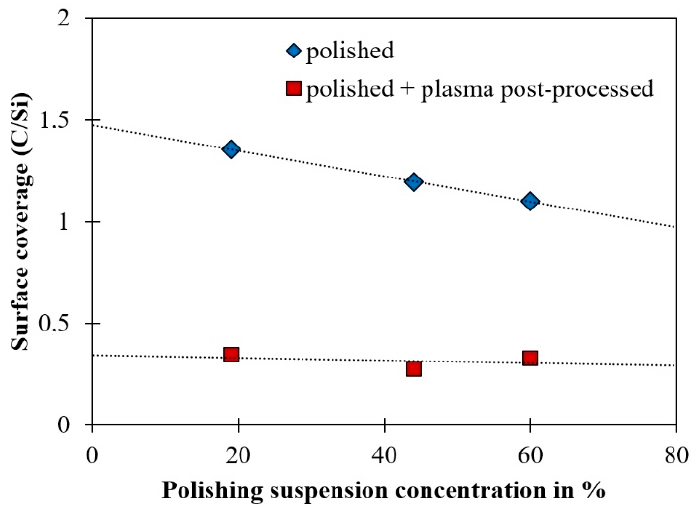
Figure 8. Comparison of the surface coverage by carbon (i.e., the ratio of carbon and silicon) of zinc crown glass samples before and after plasma post-processing vs. polishing suspension concentration including trend (dotted